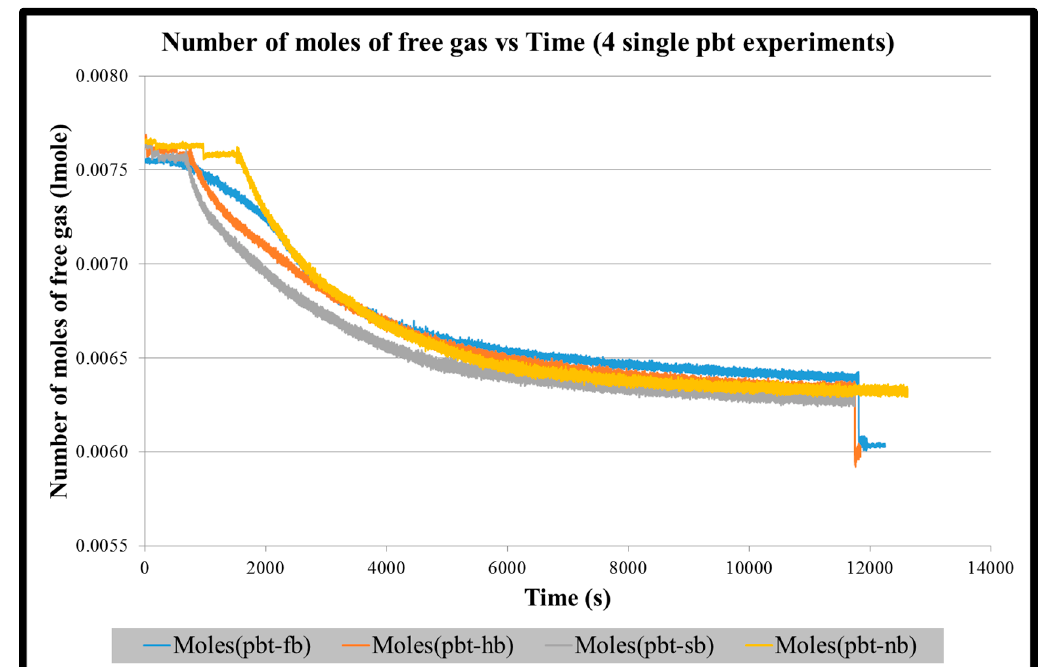
Figure A1. Number of moles of free gas vs. time for four single PBT impeller experiments until the start of stabilization of hydrate formation.